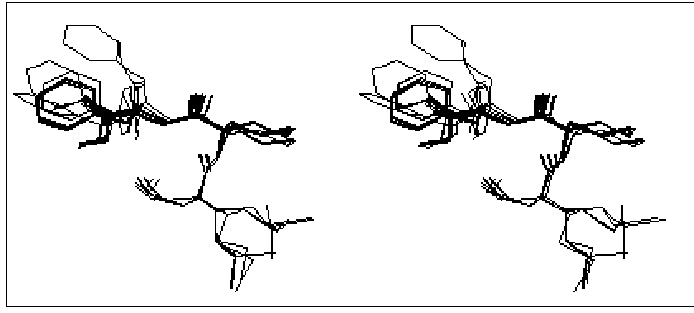
Figure 3. Stereoscopic superposition view of the 17 conformers of formyl-Met-Acc6-Phe-OMe in β turn